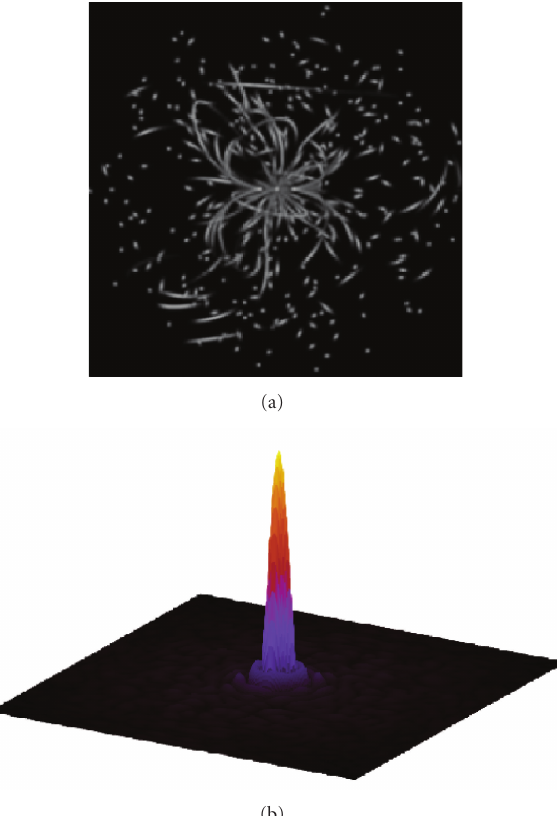
Figure 4: Above: cross-section of the computed sampling density used in reconstruction. (Below) cross-section of the psf, expanded using 8X Fourier interpolation.